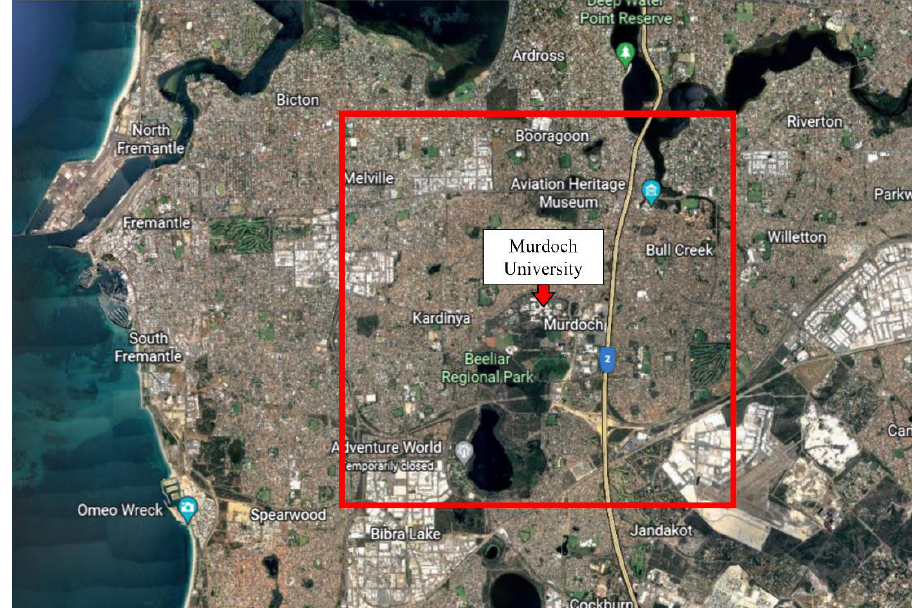
Figure 5. Enclosed area shows the area for the generated irradiance maps.